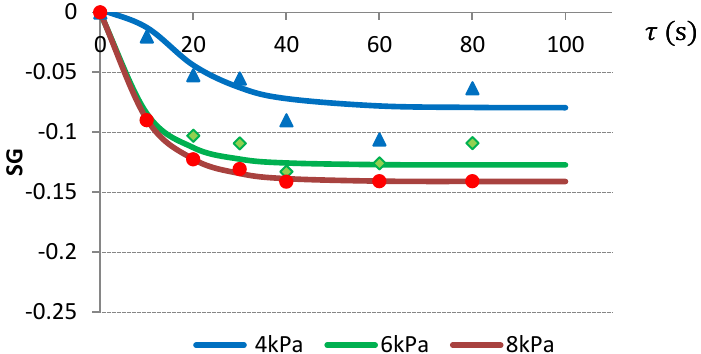
Figure 1. Changes of SG during VI of apples at varied vacuum pressures of 4, 6, and 8 kPa using citric acid solution as the impregnating liquid.